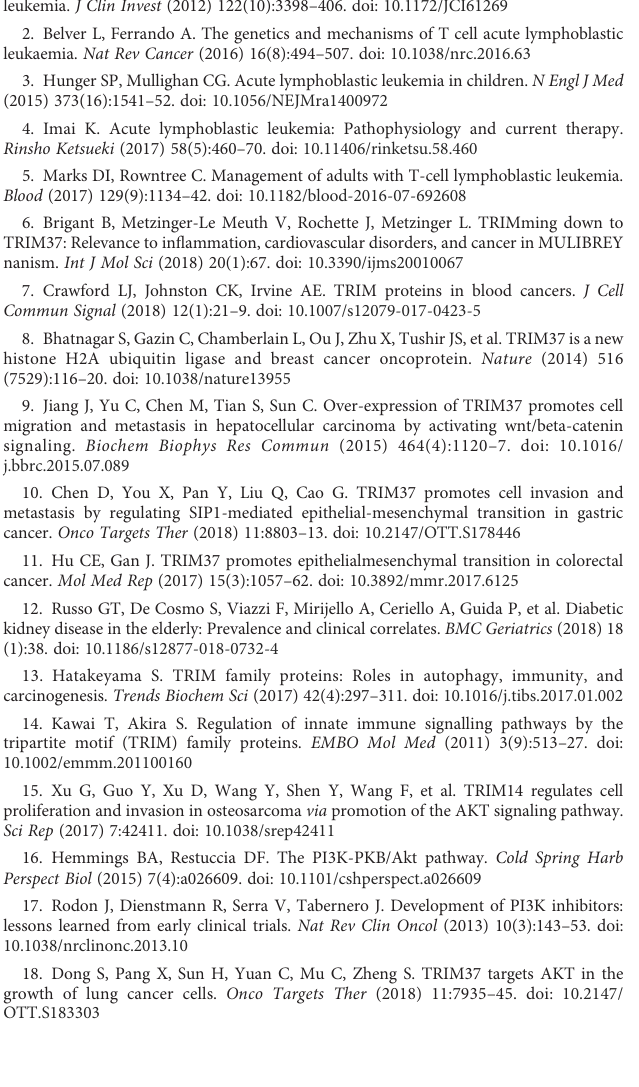
SUPPLEMENTARY FIGURE 1 TRIM37 was negatively correlated with PTEN in human T-ALL patients and normal people. *** p < 0.001, compared with normal control